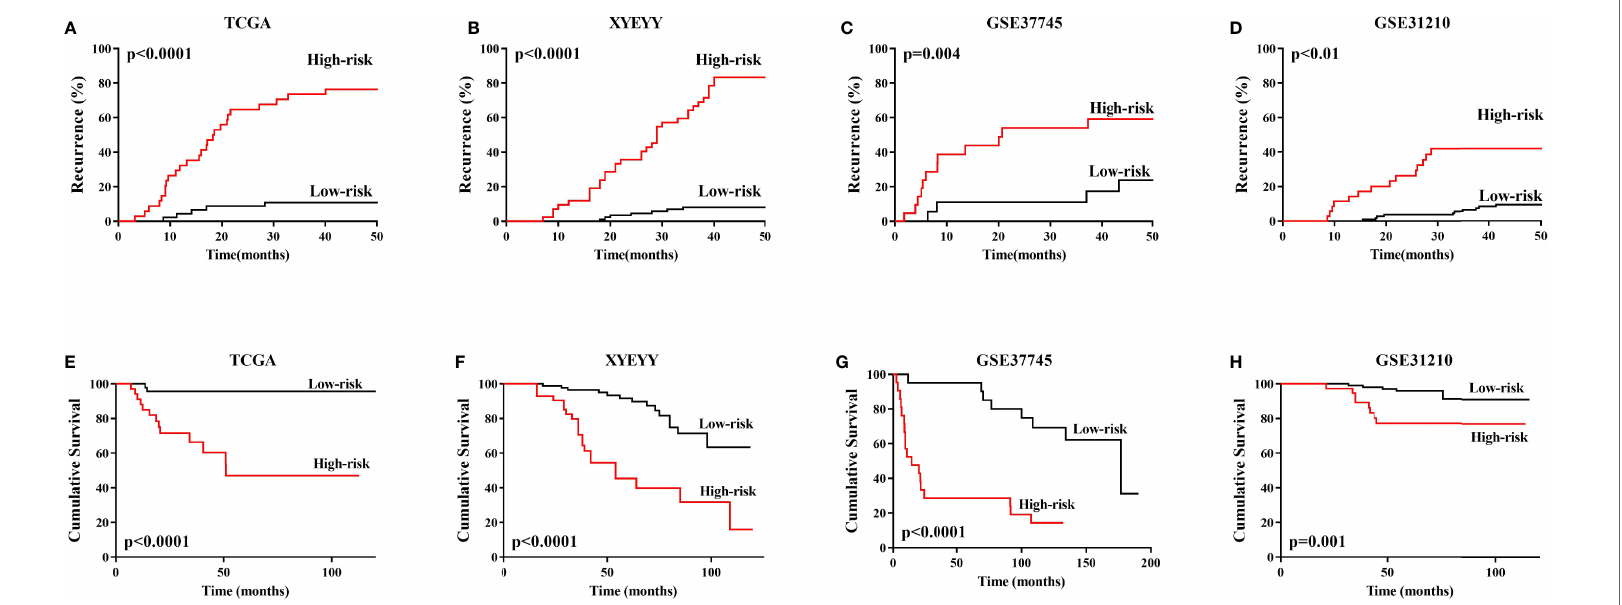
FIGURE 5 | (A – D) In TCGA training cohort, XYEYY cohort and GEO datasets, Kaplan-Meier survival analyses showed that the rate of recurrence in the high-risk group were signi fi cantly higher than that in the low- risk group. (E – H) Consistently, the mortality rate in the high-risk group were signi fi cantly higher than that in low-risk group. Patients enrolled in GSE116959 dataset was conditioned by stringent criteria such as availability of resected surgical specimens, good quality RNA and time of follow-up for surviving patients (min 40 months for surviving patients). The recurrence and vital status were recorded, unfortunately, the time from surgery to recurrence or death were not available. Similarly, the recurrence status was recorded in GSE32863, but no time details. Thus Kaplan-Meier analyses cannot be performed in these two